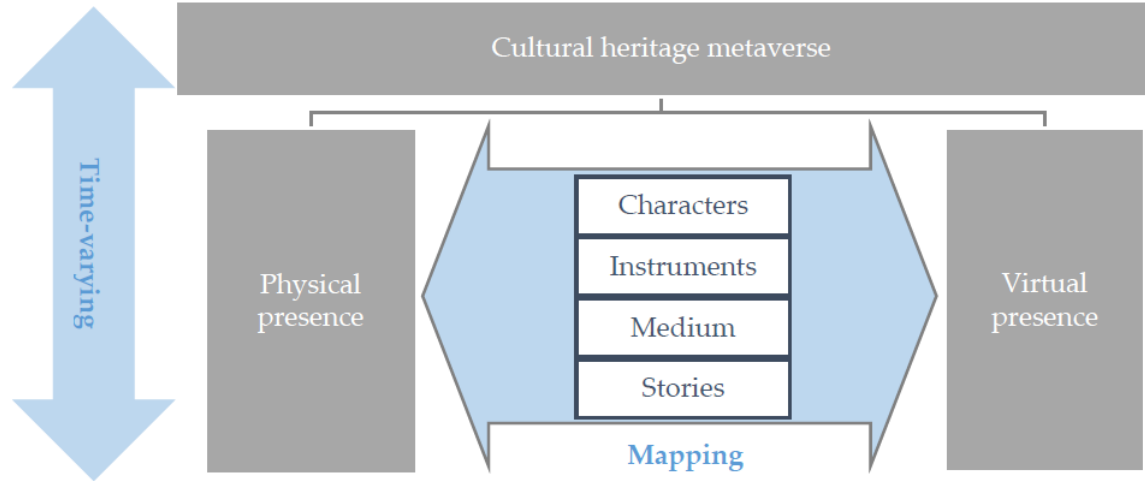
Figure 2. Framework of cultural heritage metaverse.